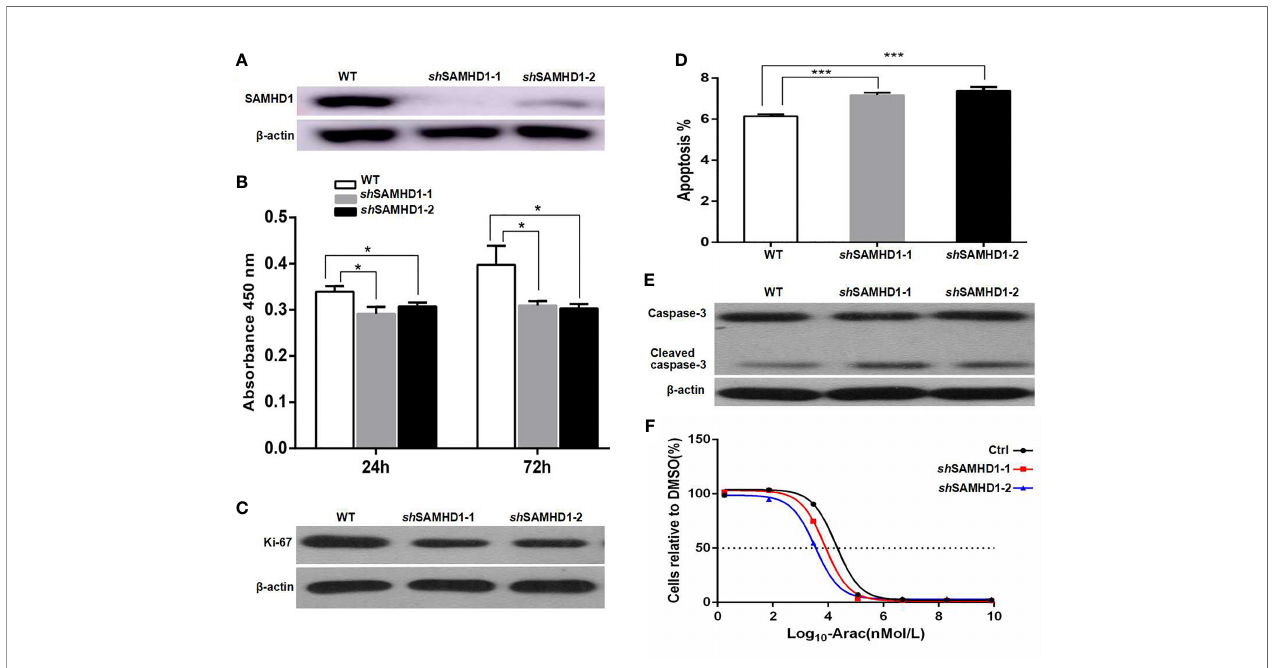
FIGURE 3 | SAMHD1 promotes the proliferation, inhibits the apoptosis, and mediates the resistance to cytarabine of MCL cells. MCL cells (Jeko-1) were cultured and their SAMHD1 gene was silenced by using two lentiviral vectors SAMHD1- sh RNA1 and 2 to generate two SAMHD1-silenced Jeko-1 cell lines ( sh SAMHD1-1 and sh SAMHD1-2). The expression of SAMHD1 in wild-type Jeko-1 cells and two SAMHD1 -silenced Jeko-1 cell lines detected by Western blot (A) . The proliferation of Jeko-1 cells. Wild-type Jeko-1 cells showed higher proliferation activity than two SAMHD1 -silenced cell lines, sh SAMHD1-1 and sh SAMHD1-2 (B) . Panel (C) is the Western blot of Ki-67 expression. Wild-type Jeko-1 cells expressed a higher level of Ki-67 protein than the two silenced cell lines, sh SAMHD1-1 and sh SAMHD1-2. SAMHD1 -silenced Jeko-1 cells (both sh SAMHD1-1 and sh SAMHD1-2) had a higher proportion of apoptosis cells than the wild-type parent cell (D) . (E) The expression of caspase-3 in the SAMHD1-1 silenced cells was the same as in wild-type Jeko-1 cells, while the level of cleaved-caspase-3 in the silenced cells was higher than the wild-type cells (E) . IC50 of cytarabine for sh SAMHD1-1 and sh SAMHD1-2 cells was lower than that for wild-type Jeko-1 (F) , indicating that SAMHD1 promoted cytarabine resistance. The symbol "*" represents p < 0.5, and "***" represents p <